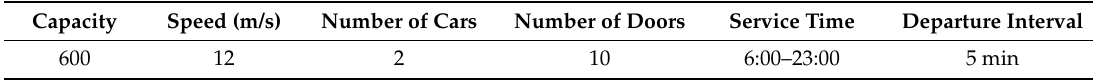
Table 3. The values of metro attributes in the simulation